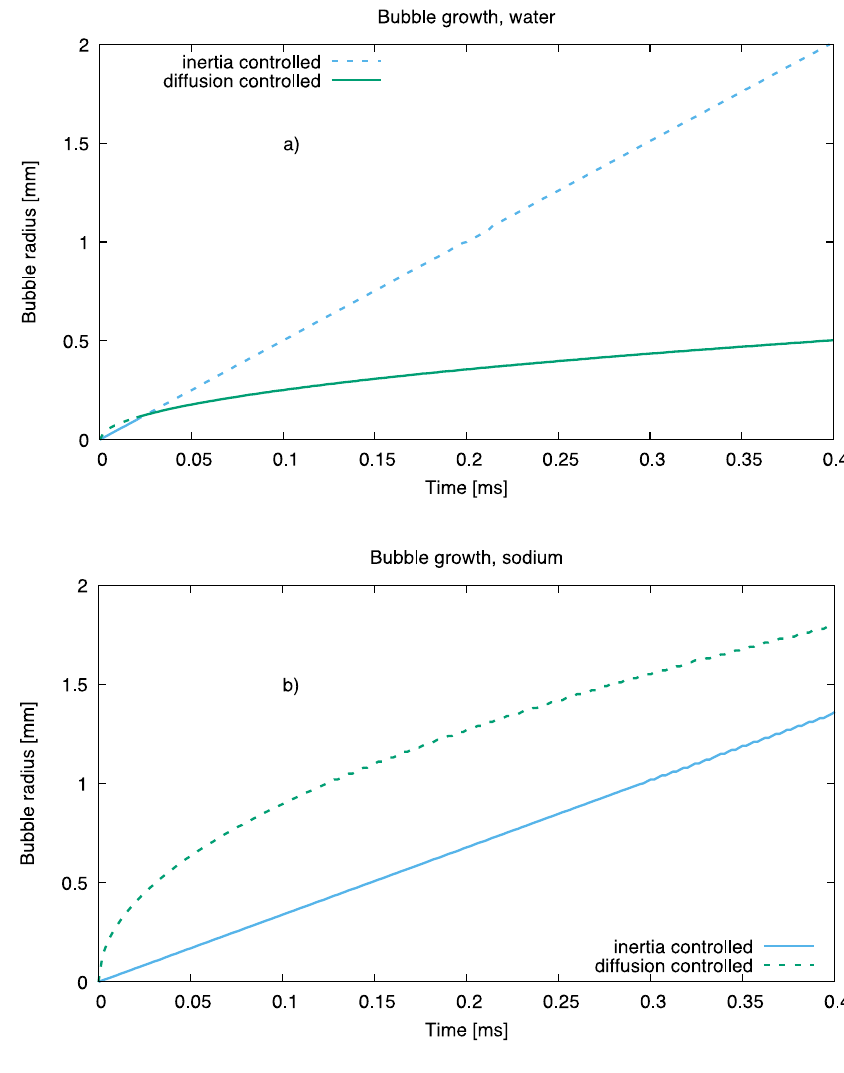
Figure 9. Bubble growth in water ( a ) and sodium ( b ) at equal superheat.